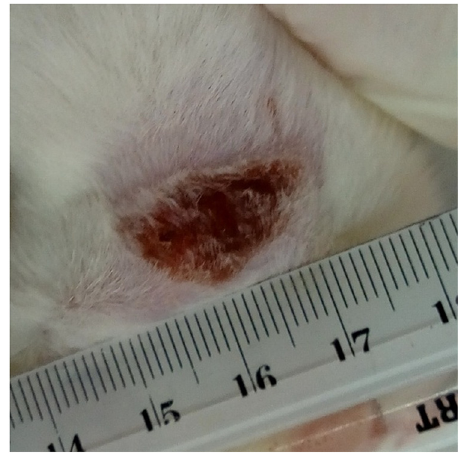
Figure 2: The burned area in fi rst - day rats.